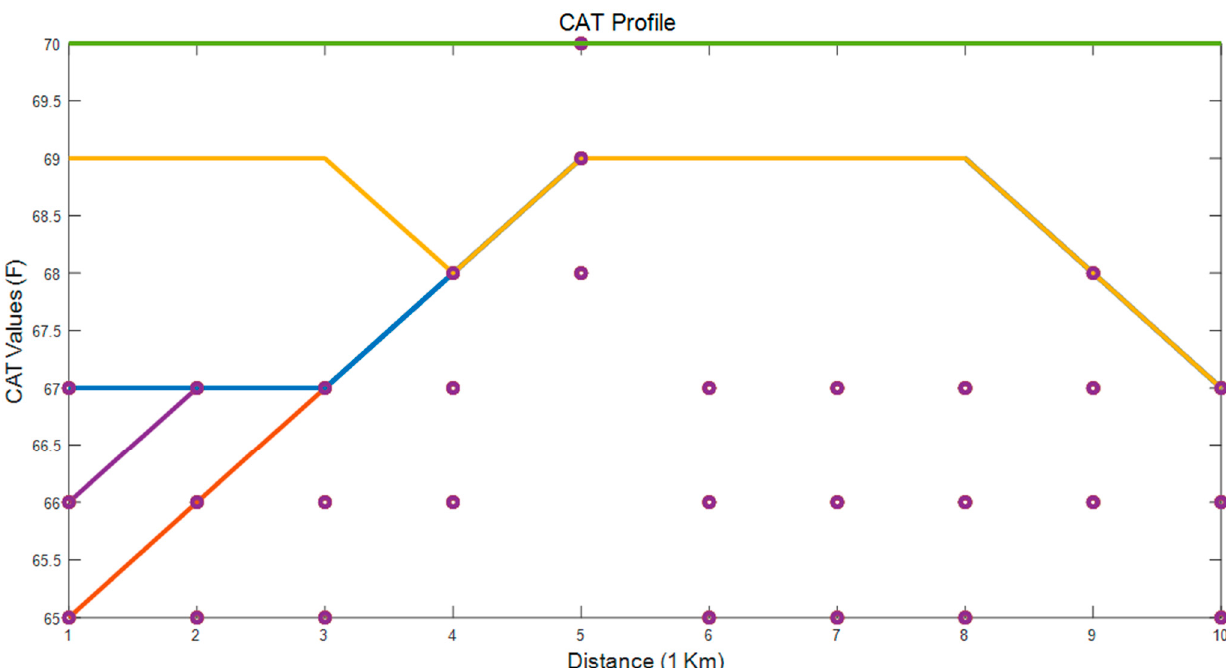
Figure 8. ACCSSP = 70 MPH; CAT = [65 70] °F; EAT = 78.75 °F.